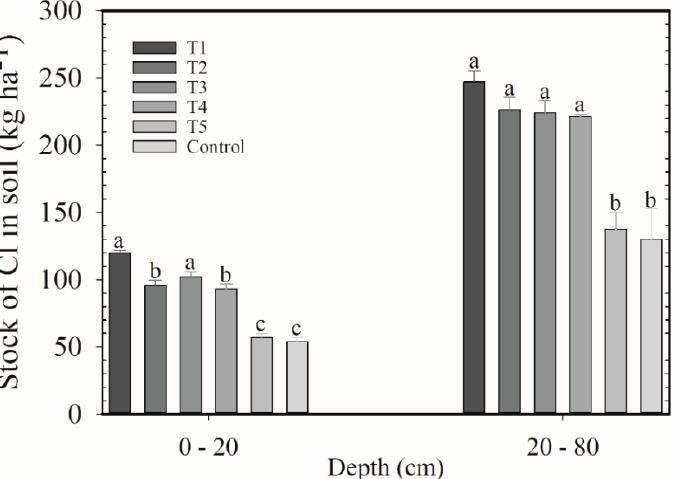
Figure 4. Stocks of Cl in the 0-20 and 20-80 cm layers after application of blends of KCl e K 2 SO 4 as cover fertilization. Harvest of 2019/2020. Means followed by the same letter in the column do not differ according to Tukey’s test ( p < 0.05). Vertical bars indicate the standard error of the mean ( n = 4). T1: 100% KCl; T2: 75% KCl + 25% K 2 SO 4 ; T3: 50% KCl + 50% K 2 SO 4 ; T4: 25% KCl + 75% K 2 SO 4 ; T5: 100% K 2 SO 4 ; control did not receive K 2 O.